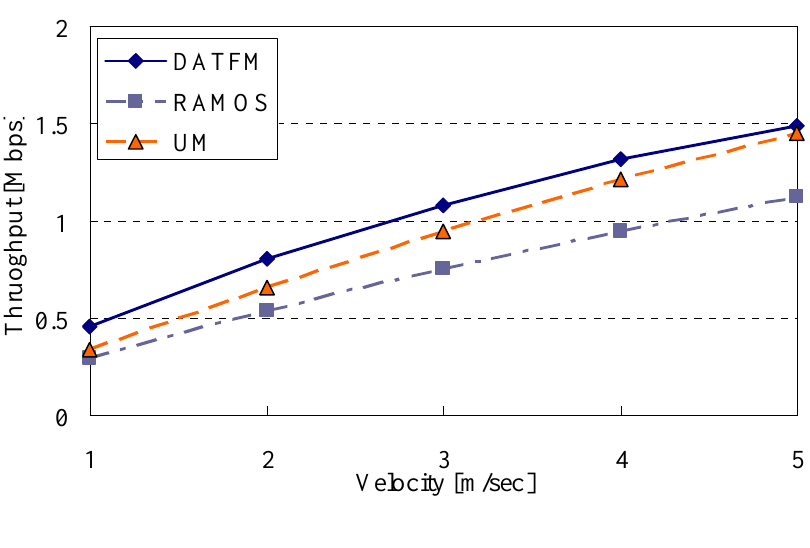
Figure 12. Velocity and average moving